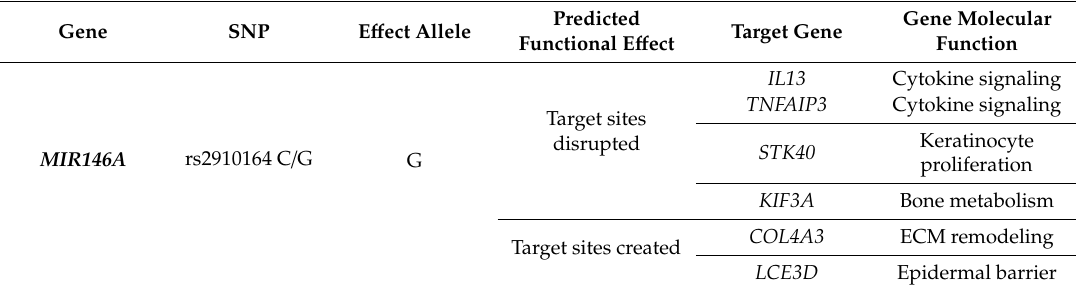
Table 3. Predicted e ff ects of the rs2910164 C / G variant on the binding activity of MIR146A (miR-146a-3p) and the molecular functions of target genes potentially related to Ps /